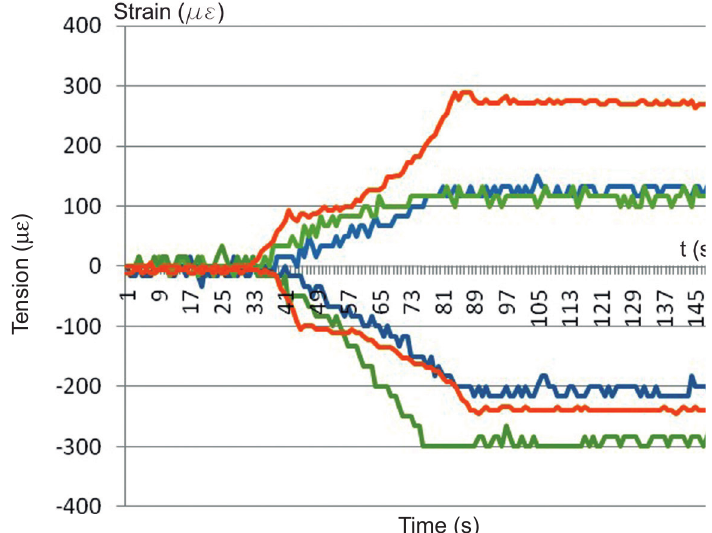
Figure 4- Measurements for tension (positive values) and compression (negative values) forces applied at 15 mm of the distal implant for the different tested